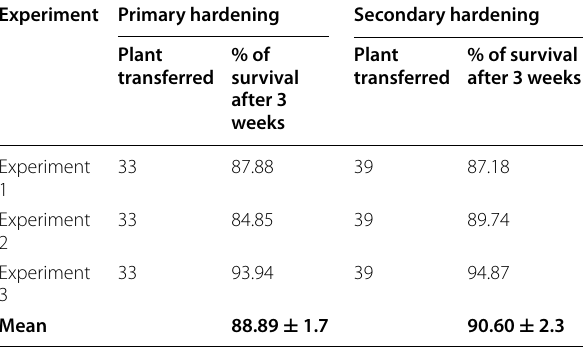
Table 5 Acclimatization of Artocarpus heterophyllus L. Experiment Primary hardening